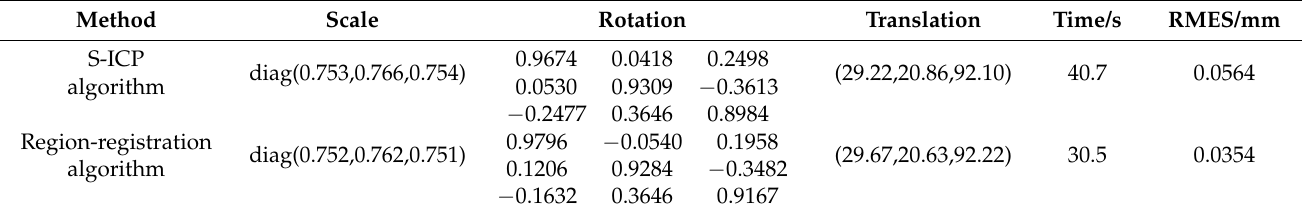
Table 1. Comparing the registration results of the two methods.